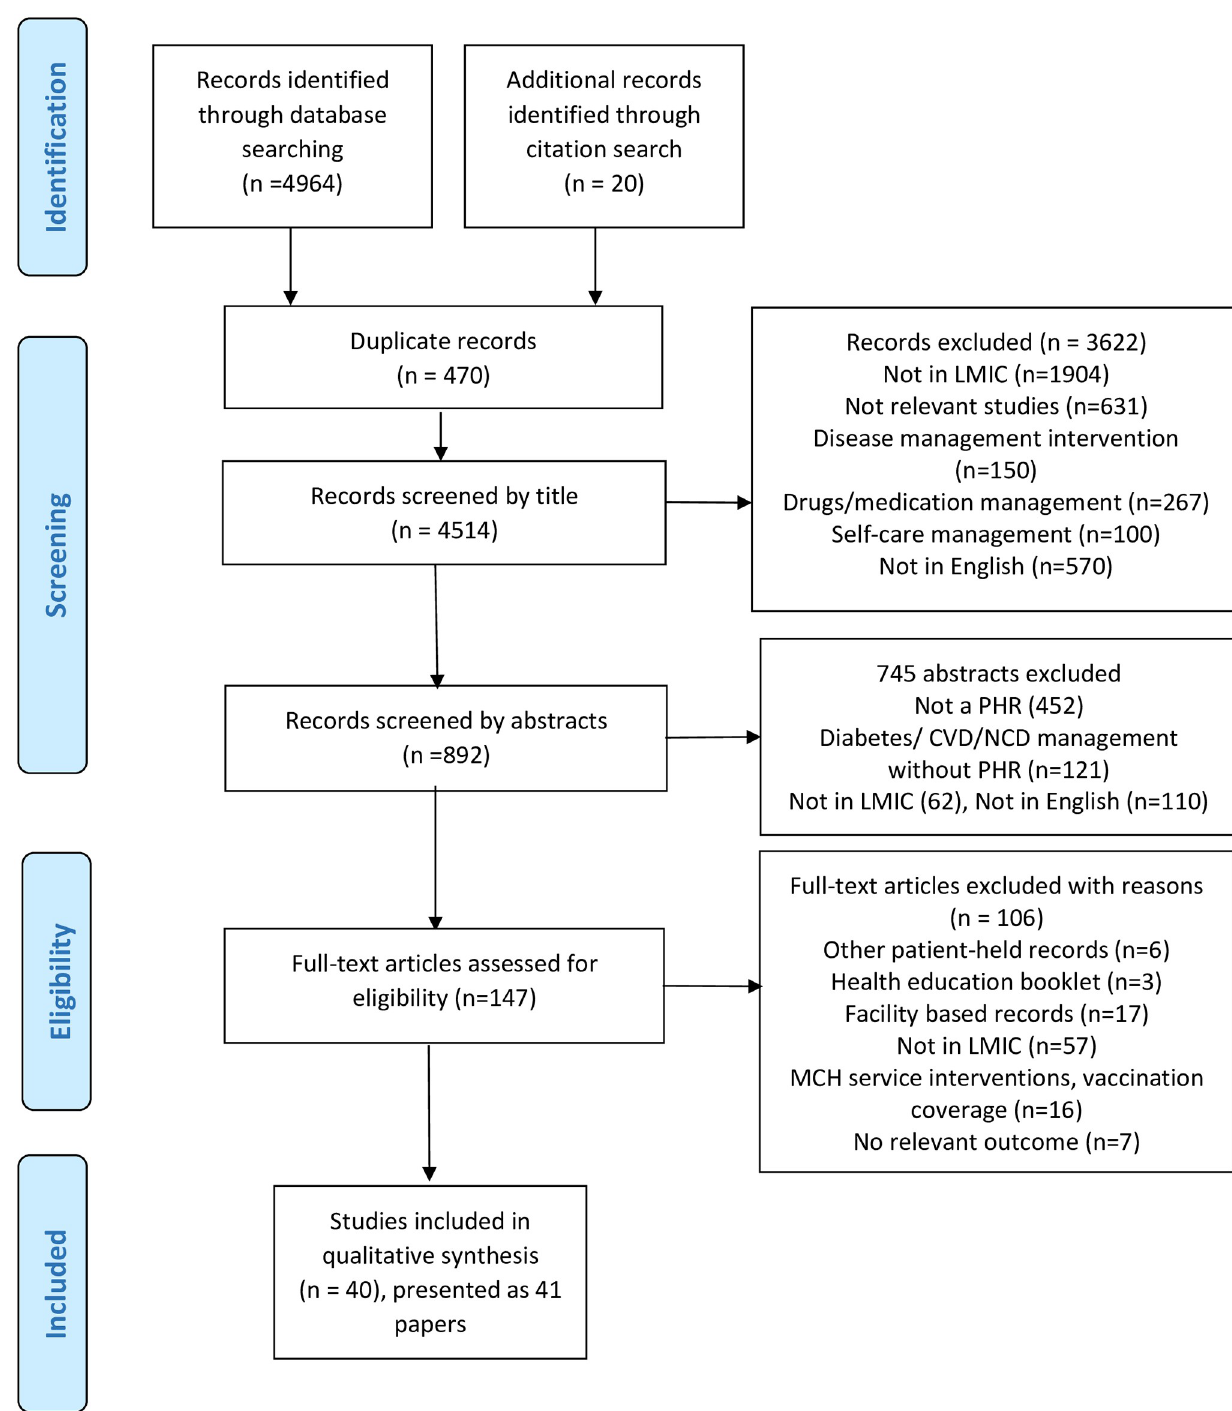
Fig 1. Preferred Reporting Items for Systematic Reviews and Meta-Analyses (PRISMA) flow diagram. LMIC = Low and middle-income countries, CVD = Cardiovascular disease, PHR = Patient-held health record, NCD = Non-communicable disease, MCH = maternal, and child health.